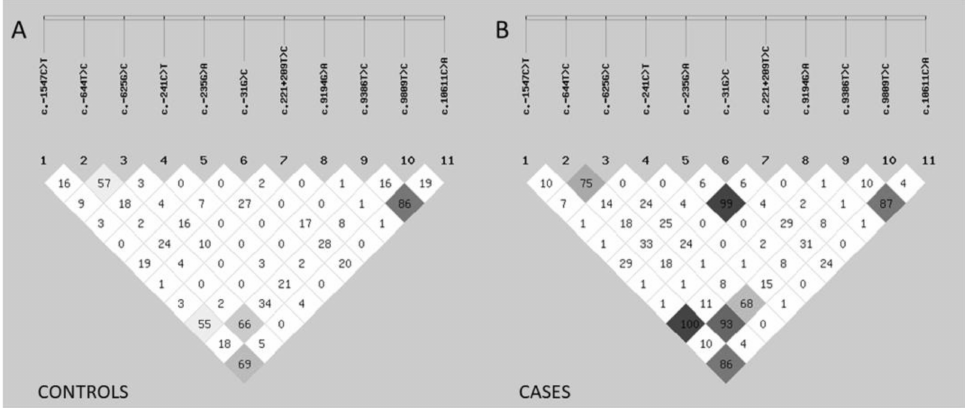
Figure 7. Pairwise linkage disequilibrium (LD) of eleven BIRC5 sequence variants with highest minor allele frequency. The location of each sequence variant along the BIRC5 gene is relative to the real nucleotide position. The number in each diamond indicates the intensity of LD (r 2 × 10 2 ) between respective pairs of sequence variants. The LD strength is also represented by shades of gray (0 [white] < r 2 < 1 [black]). ( A ) Controls. ( B )